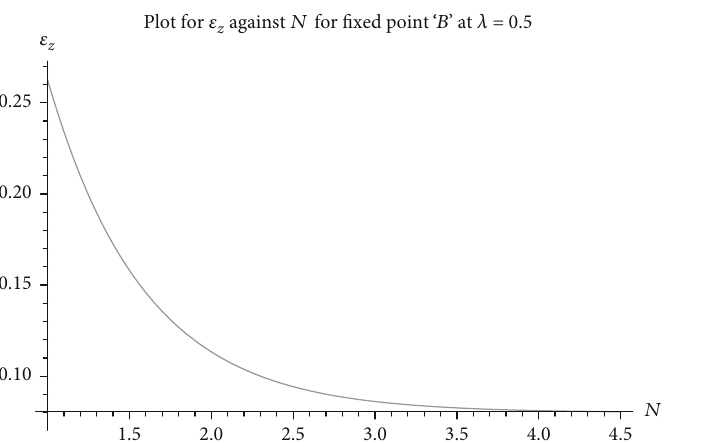
Figure 15: Shows the variation of perturbations along the z -axis, ϵ